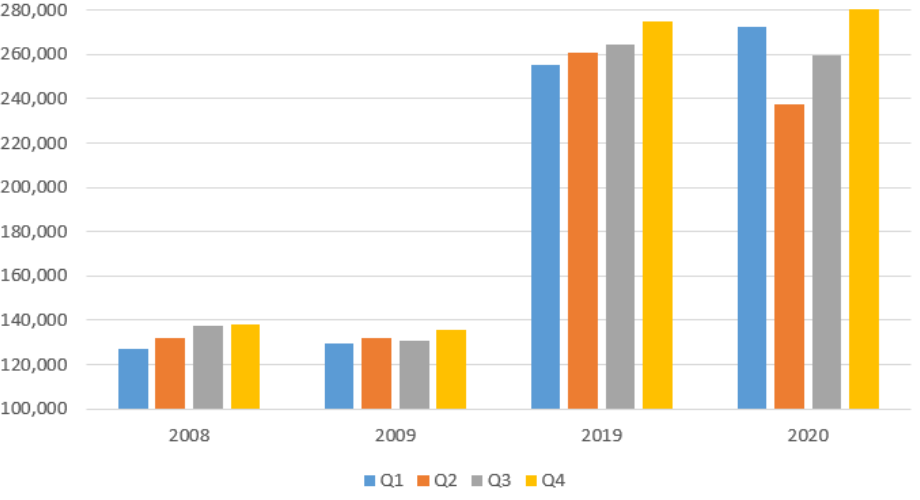
Figure 2. Evolution of GDP during financial crisis and COVID-19 crisis.